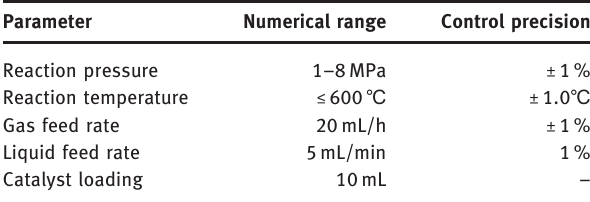
Table 3 listed out silica alumina ratio of the three kinds of molecular sieve catalyst. Silica alumina ratio of C-X is the highest of the three kinds of molecular sieve catalyst. It